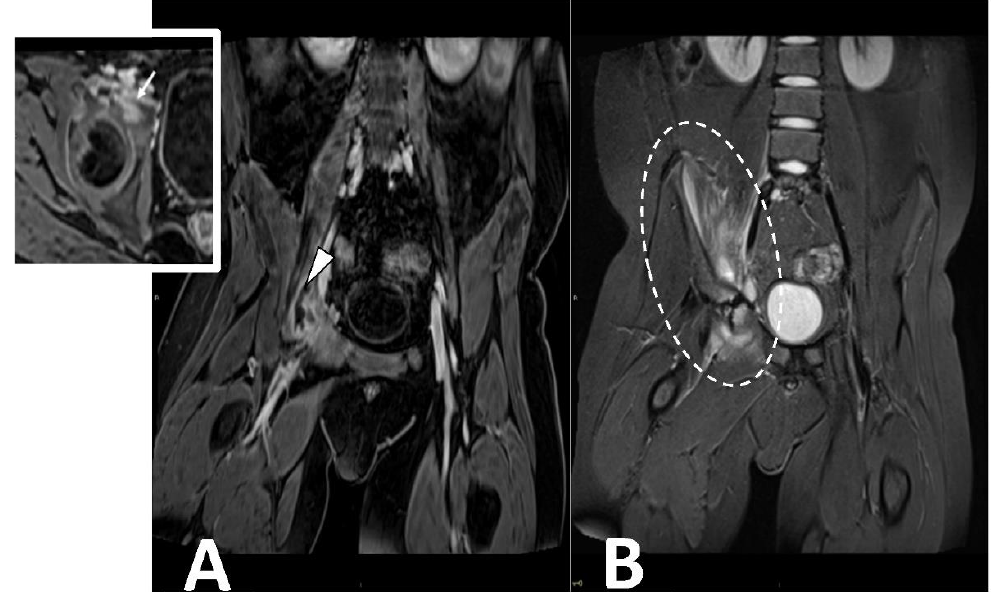
Figure 7. CE MRI in a 10-year-old boy presenting with limping and fever. Coronal ad axial T1 vibe FS post-contrast images (Panel A ) demonstrate a bone infectious focus in the acetabulm (arrow) and a large abscess in the iliac and pettineus muscle with a peripheral rim enhancement (arrowhead). Coronal stir (Panel B ) shows bone marrow edema in the acetabulum with enlargement and inflammation of surrounding muscular structures (oval dotted line).